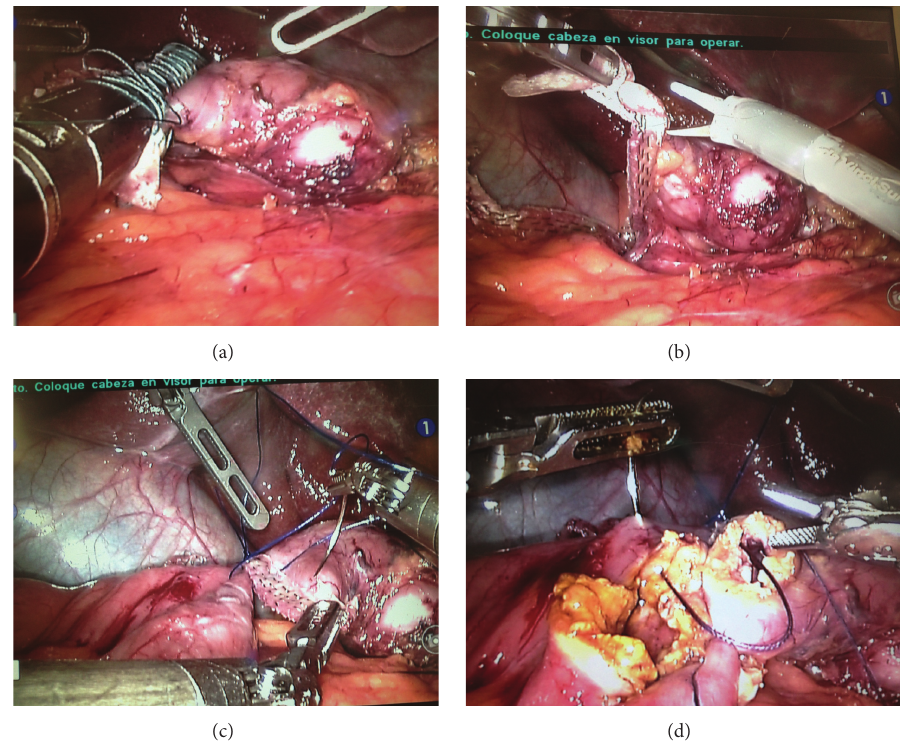
Figure 2: Complete transection of the duodenum (a). Excision of the buttress material reinforcement material located on the gastric part (b). Duodenoileal anastomosis, posterior polypropylene layer (c). Posterior continuous resorbable suture